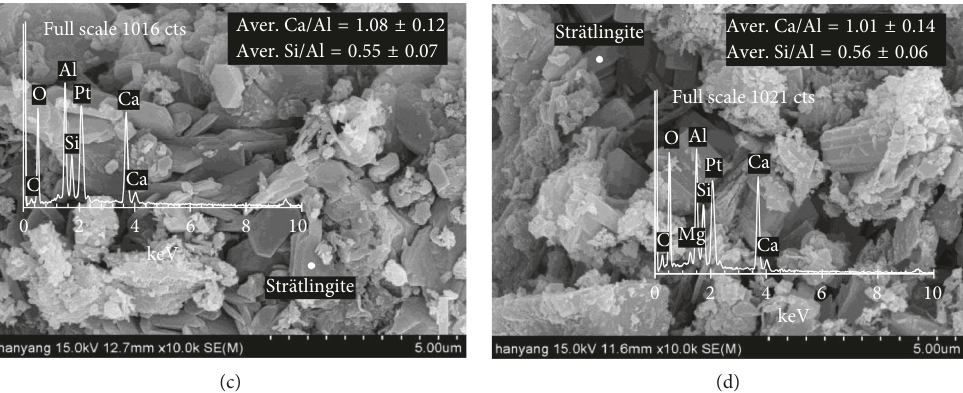
Figure 8: Microscopic observation for the formation of str¨atlingite in paste of CAC-GGBS mixtures at 365 days of curing. The standard deviation is derived from the measurements in 30 spots for each sample ( n � 30): (a) CAC 100; (b) CAC 80; (c) CAC 60; (d) CAC